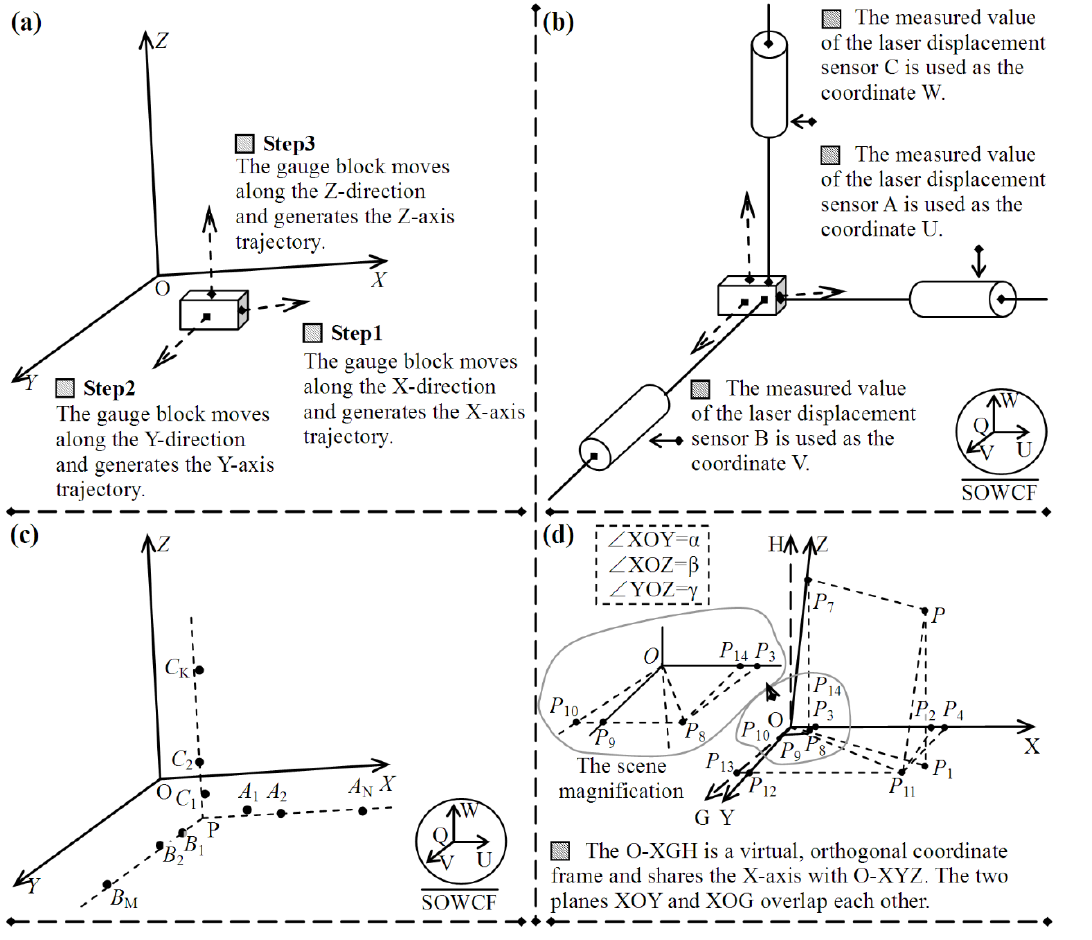
Figure 4. The procedure of the orthogonality estimation and the orthogonality correction. ( a ) The motion control system carries the gauge block to move along the X-direction, the Y-direction and the Z-direction. ( b ) The variations of the displacement are measured by the three laser displacement sensors. ( c ) The test points are used to simulate the motion trajectories, and the intersection angles of the motion trajectories are calculated. ( d ) The intersection angles of the motion trajectories obtained by the steps ( a – c ) are used to correct the coordinates of the motion control system.